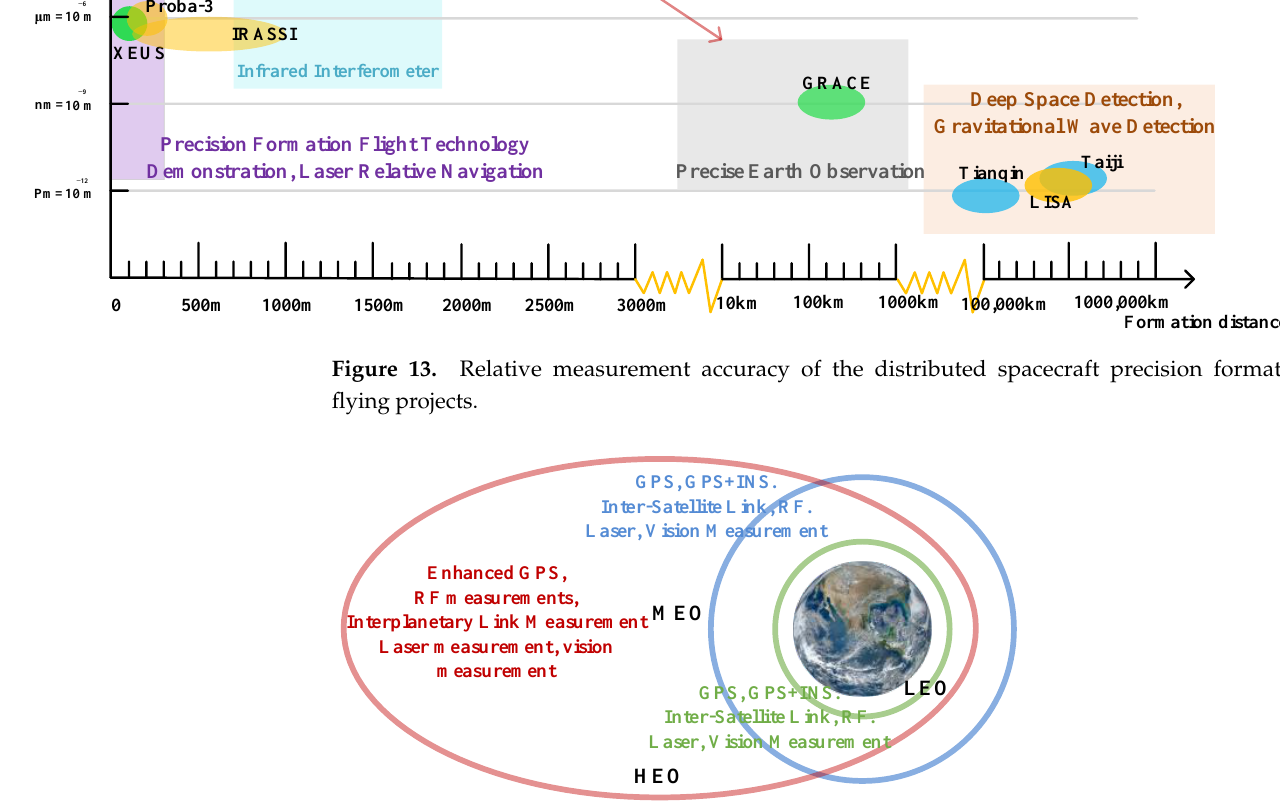
Table 6. The precise formation parameters of each project.